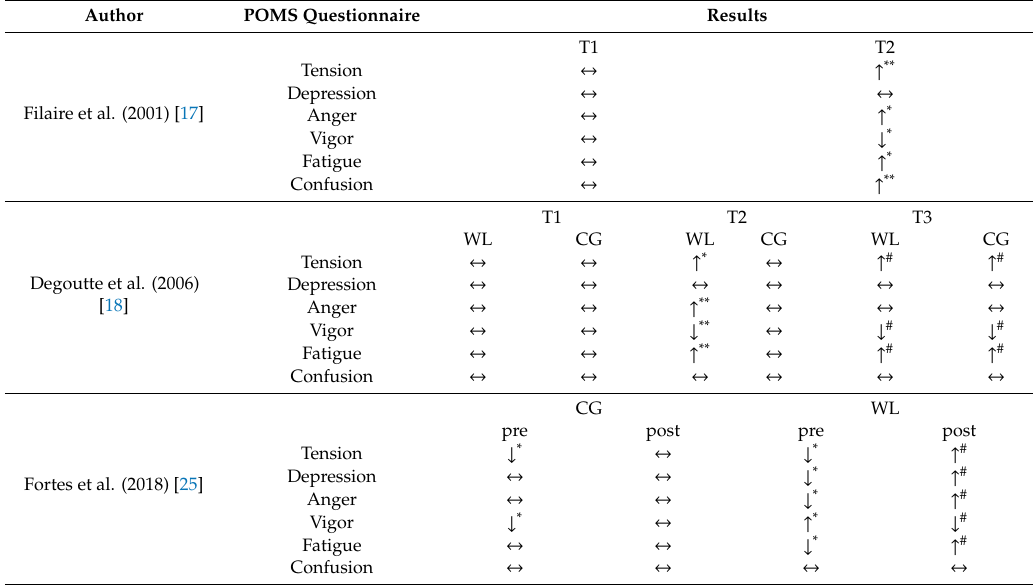
Table 4. E ff ects of rapid weight loss on the psychological well-being in